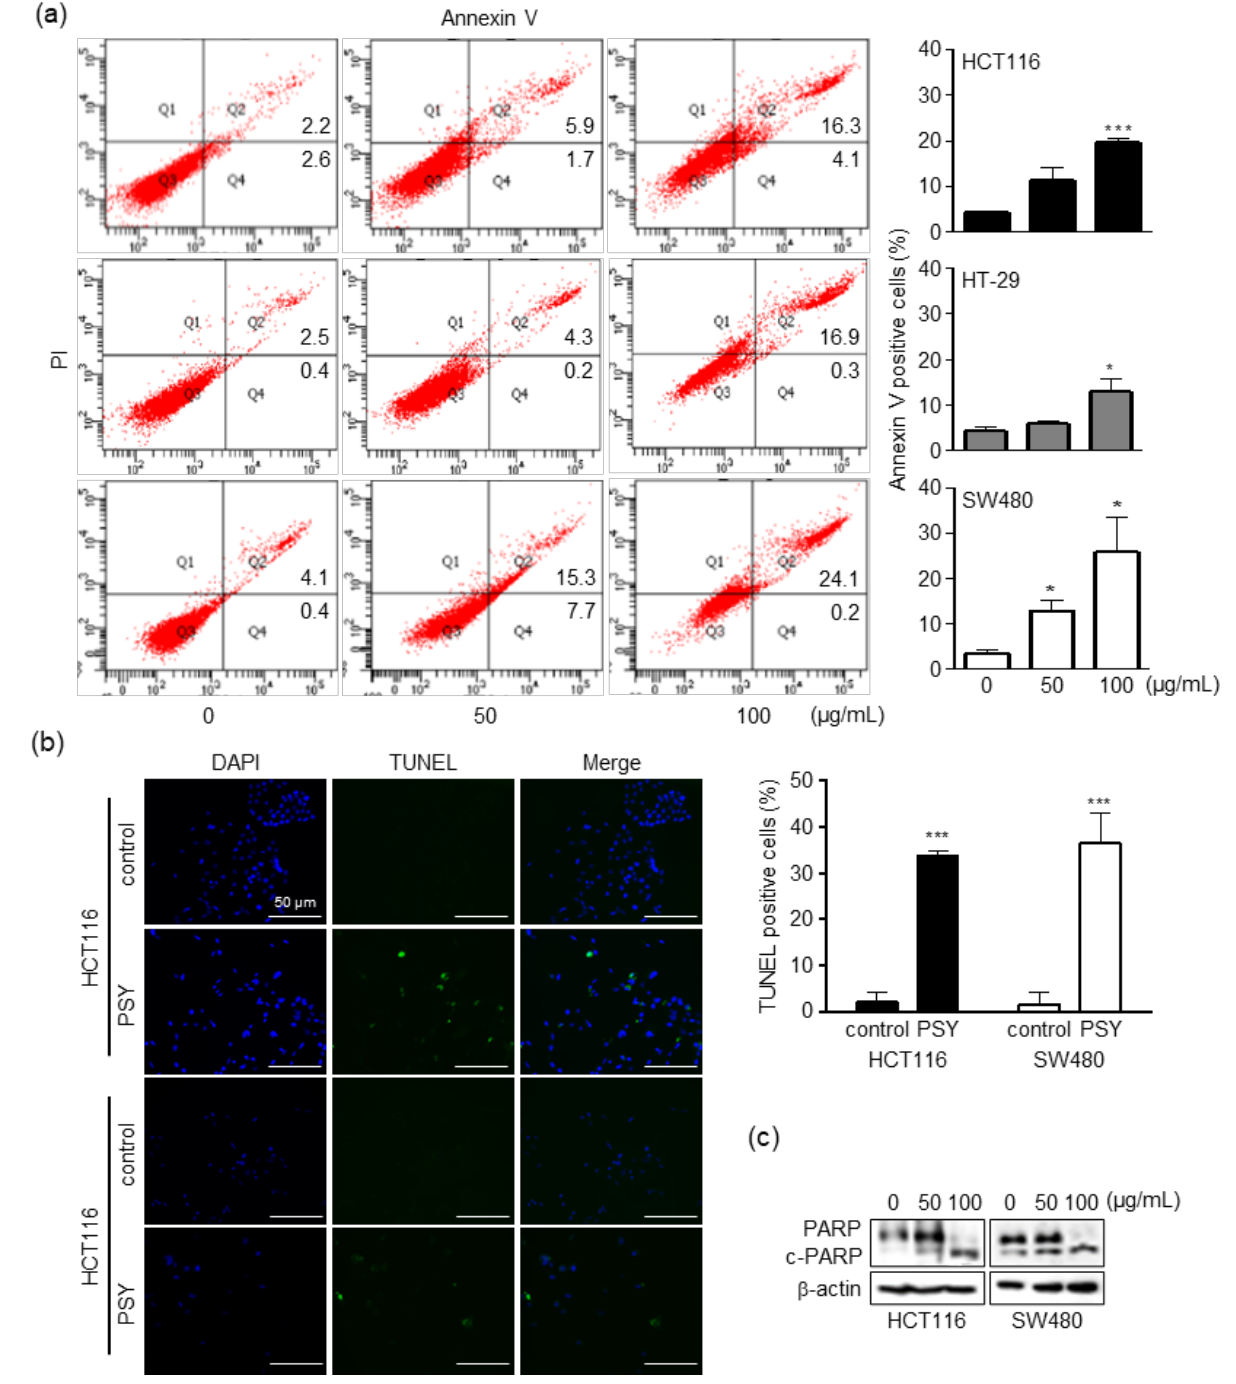
Figure 3. Effects of PSY on apoptosis in human CRC cells. CRC cells were treated with PSY EtOH-Ex for 48 h. ( a ) The cells were double-stained with FITC-Annexin V and PI and analyzed using flow cytometry (left panel). ( b ) The TUNEL and DAPI staining of the PSY (50 μg/mL) -treated cells were analyzed by confocal microscopy (left panel). Scale bar, 50 μm. Apoptotic cells were quantified as a percentage of Annexin V-positive and TUNEL-positive cells (right panel in a , b , respectively). Data present the mean ± SEM of three independent experiments (*, p < 0.05 and ***, p < 0.001 versus control). ( c ) Whole lysates of the treated cells were subjected to Western blotting for PARP and cleaved PARP (c-PARP). β -actin was used as an internal control.